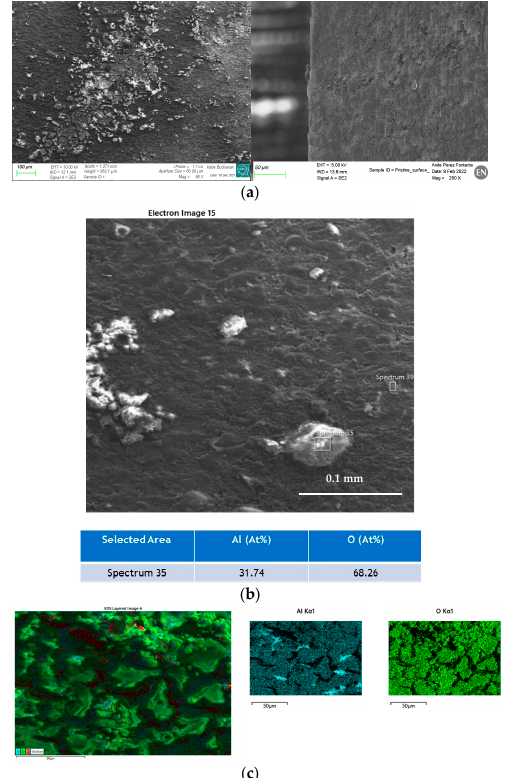
Figure 8. ( a ) Left: SEM view of the outer surface of the PM sample subjected to a temperature (70 °C) and humidity (RH = 100%) cycle for 60 h. Evidence of corrosion spots and corrosion residues (whitish phase) featuring poor adherence on the surface. Right: as above, the GPI sample features large areas with no visible corrosion events. ( b ) EDS analysis of the whitish phase of the PM sample, mainly consisting of Al and O (32 at.% Al and 68 at.% O), close to Al 2 O 3 composition. ( c ) EDS mapping of the distribution of Al and O on the sample surface.